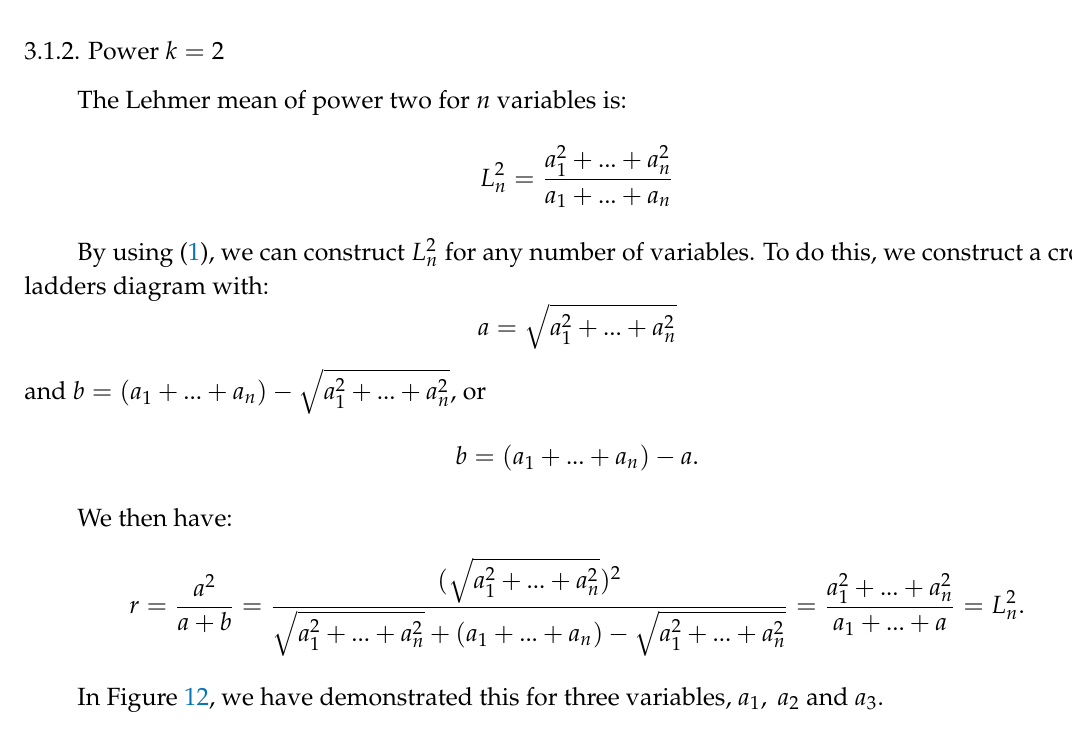
Figure 13: Lehmer means constructed in the bisymmetric crossed ladders diagram. 18